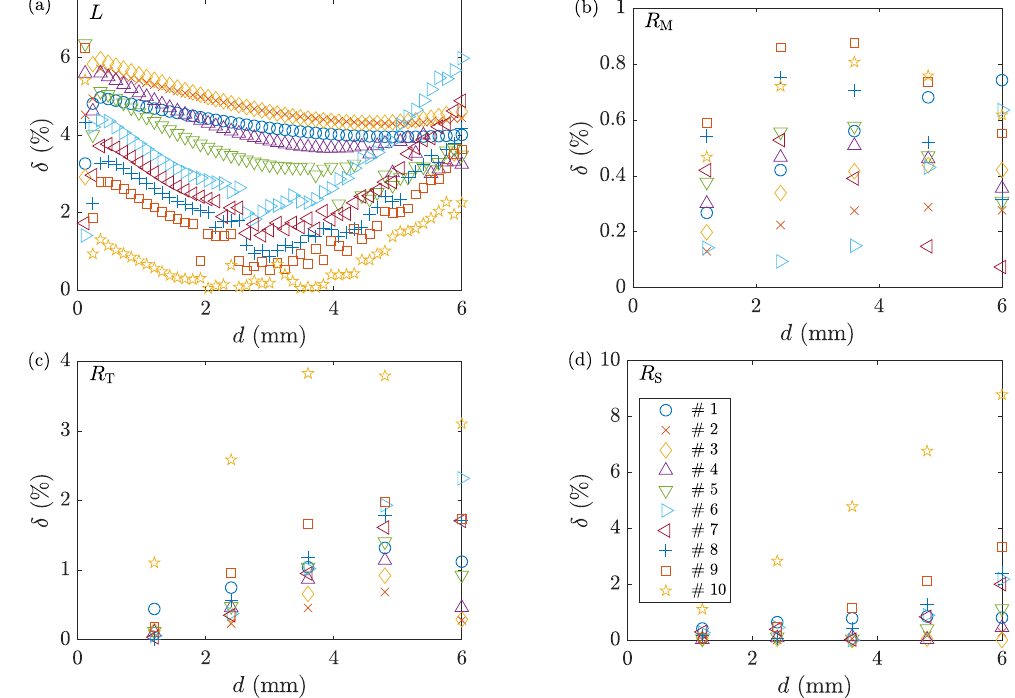
Figure 13. The percent error of ( a ) deformation load, and profile’s ( b ) R M , ( c ) R T , and ( d ) R S obtained from comparing ACTS and FE models. The symbols are to be read from the legend in the subplot ( d ) that refers to the corresponding sample number in Table 1.